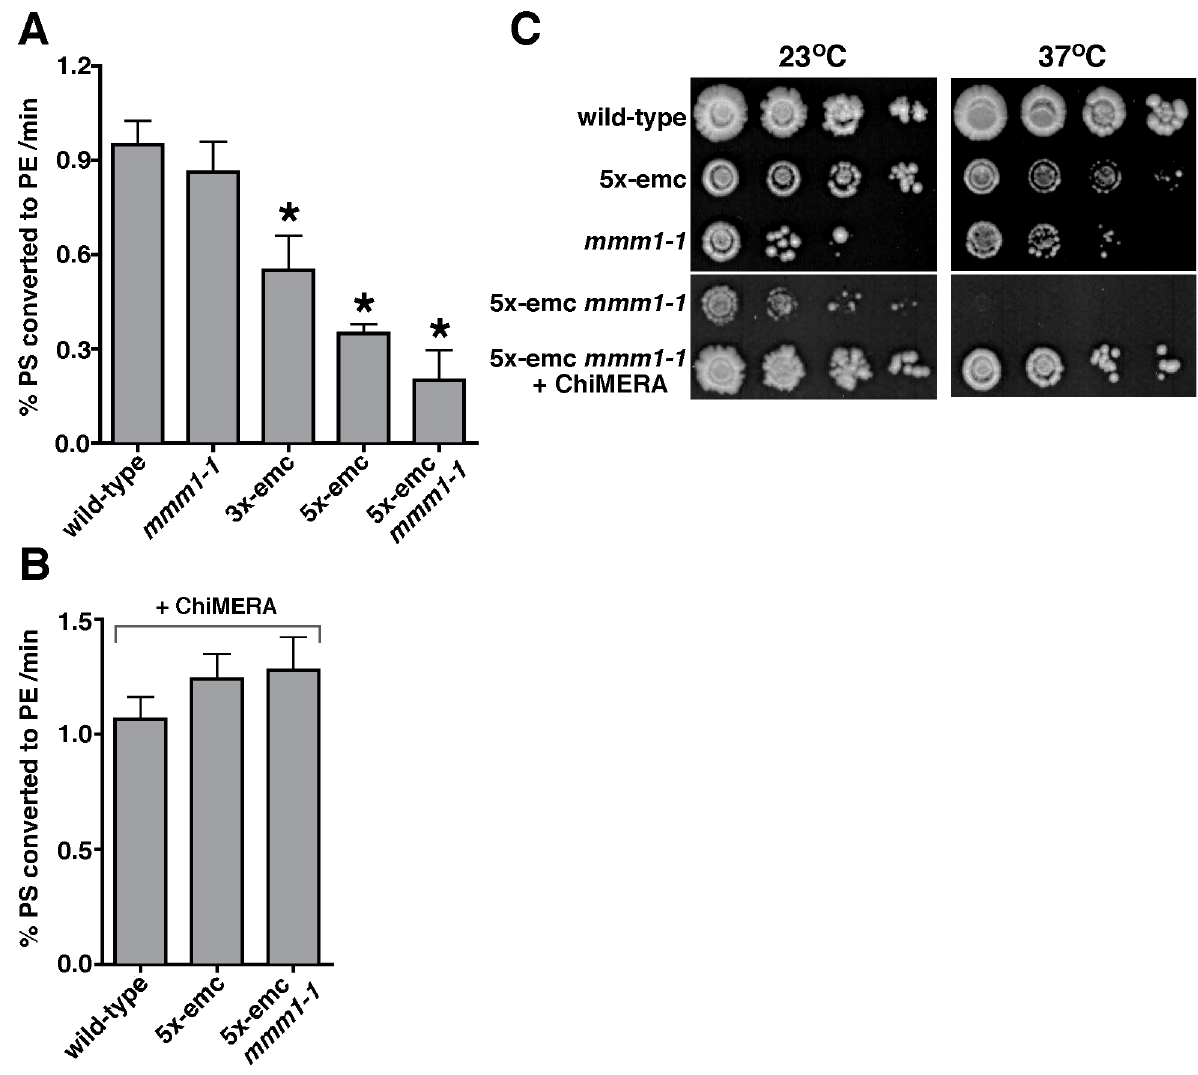
Figure 6. 5x-emc mmm1-1 cells are not viable and have a dramatic reduction in ER to mitochondria PS transfer at nonpermissive temperature. (A) Crude mitochondria were incubated with [ 3 H]serine and Mn 2 + . After 20 min at 30 u C, EDTA and an excess of unlabeled serine were added; chelation of Mn 2 + by EDTA inhibits PS synthase and allows Psd1 to function. The samples were collected over 15 min, and the rate of [ 3 H]PS to [ 3 H]PE conversion per minute was calculated (mean 6 s.d., n =3–5 independent experiments). * p , 0.05 compared to wild-type, two-tailed t test. (B) The rate of PS to PE conversion of strains expressing ChiMERA was determined as in (A) (mean 6 s.d., n =3 independent experiments). The data used to generate panels A and B are in Table S6. (C) Cultures of strains with the indicated genotypes were grown at 23 u C and 10-fold serial dilutions were spotted on to YPD plates and incubated at 23 u C or 37 u C for 4 d.